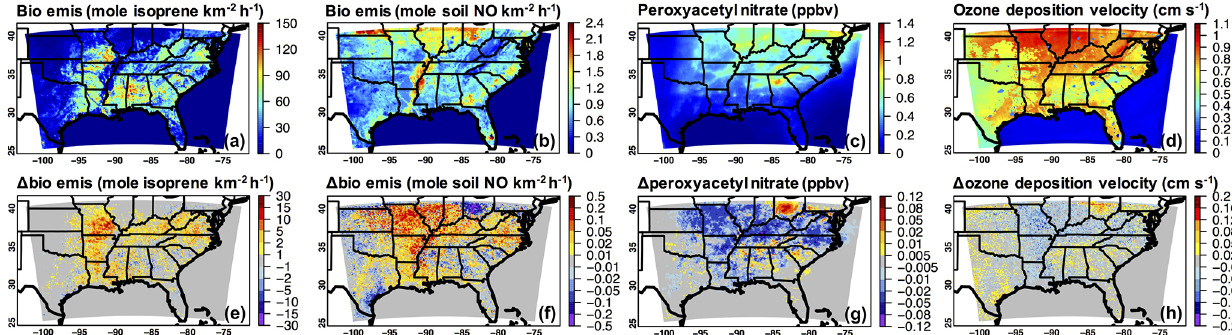
Figure 9. Period-mean (16–28 August 2016) WRF-Chem base case daytime biogenic emissions of (a) isoprene and (b) soil nitric oxide (NO); (c) surface peroxyacetyl nitrate concentration; and (d) O 3 deposition velocity, as well as (e–h) the impacts of SMAP DA on these model fields. Additional results of these variables are shown in Fig.